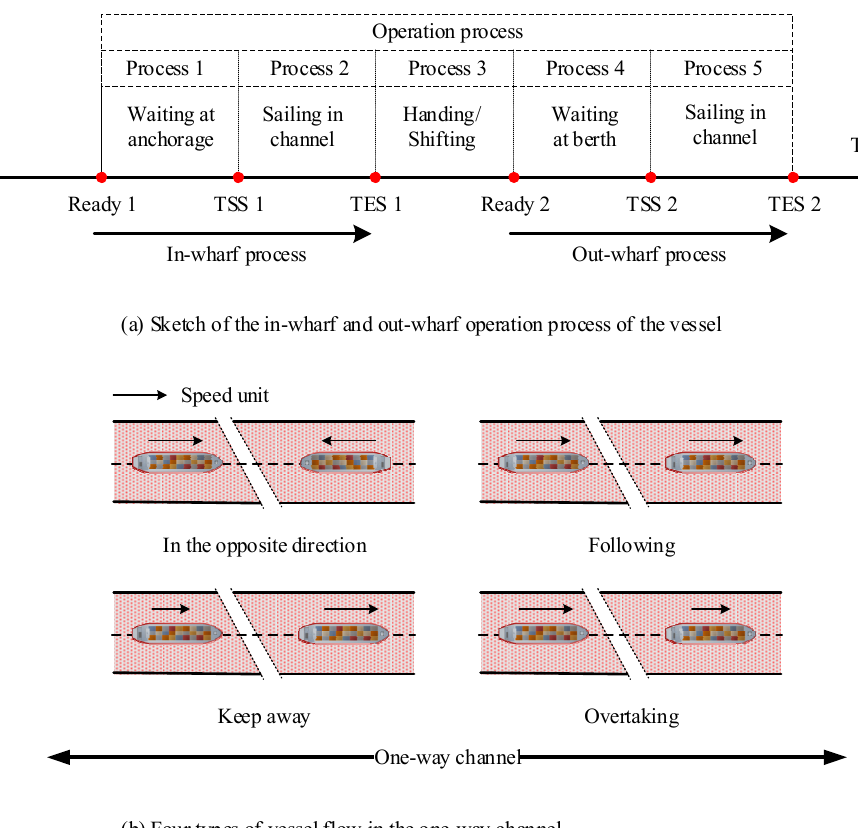
Figure 3. Schematic diagram of the ship operation process and traffic flow.